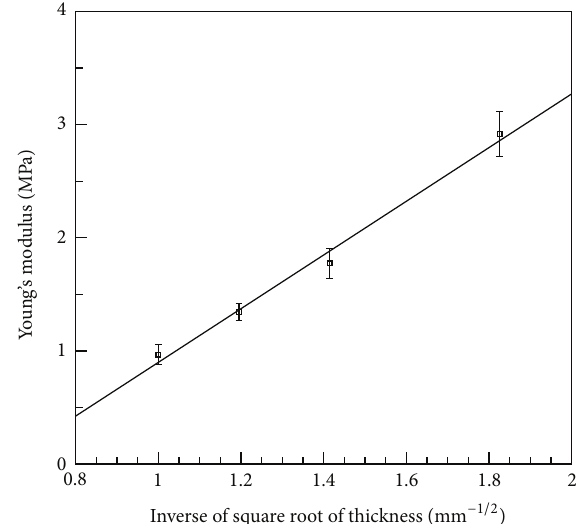
Figure 3: Young’s modulus of the PDMS membrane versus the inverse of the square root of the thickness.